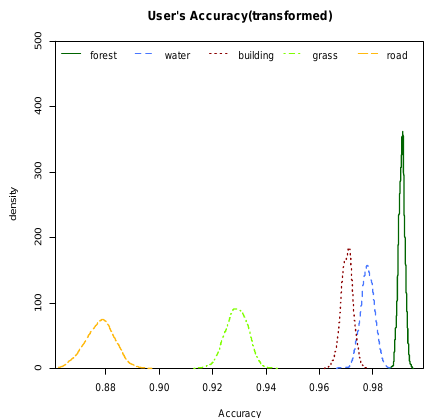
Figure 6. Distribution of user’s accuracy with five classes.